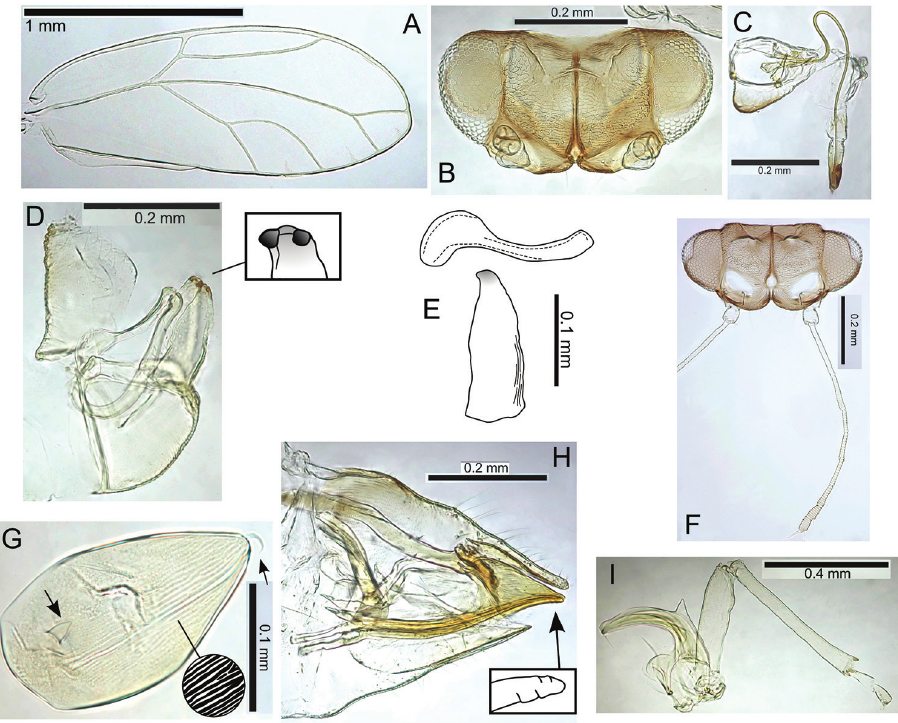
Figure 13. Pariaconus lona sp. n. A fore wing B head C proboscis D male terminalia with interior view of paramere apex (inset) E aedeagus and paramere F head and antenna G egg (pedicel, tail, and striations indicated) H female terminalia (ovipositor serrations indicated) I hind leg.